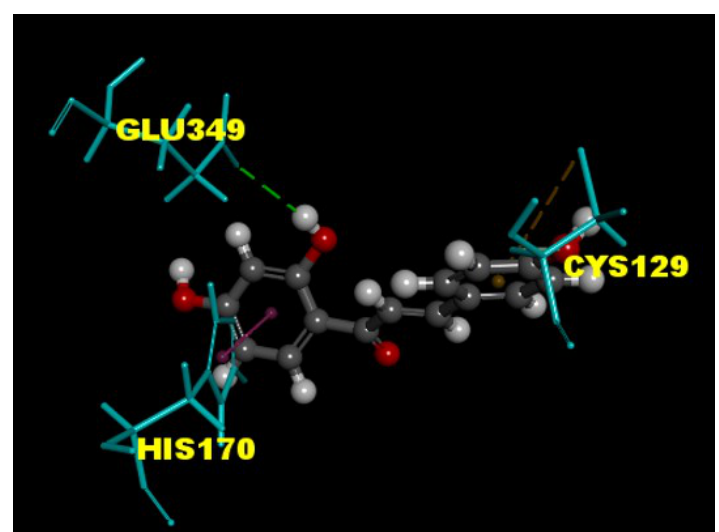
Figure 5. Estimate the binding mode of ISL into GABA B receptor using molecular docking. Binding mode between ISL with the binding site of molecular structure of GABA B receptor (PDB ID 4MGF) was estimated by the Discovery Studio 4.1 software. Protein-ligand hydrogen-bonding and van der Waal interactions are displayed as green and dark purple lines.